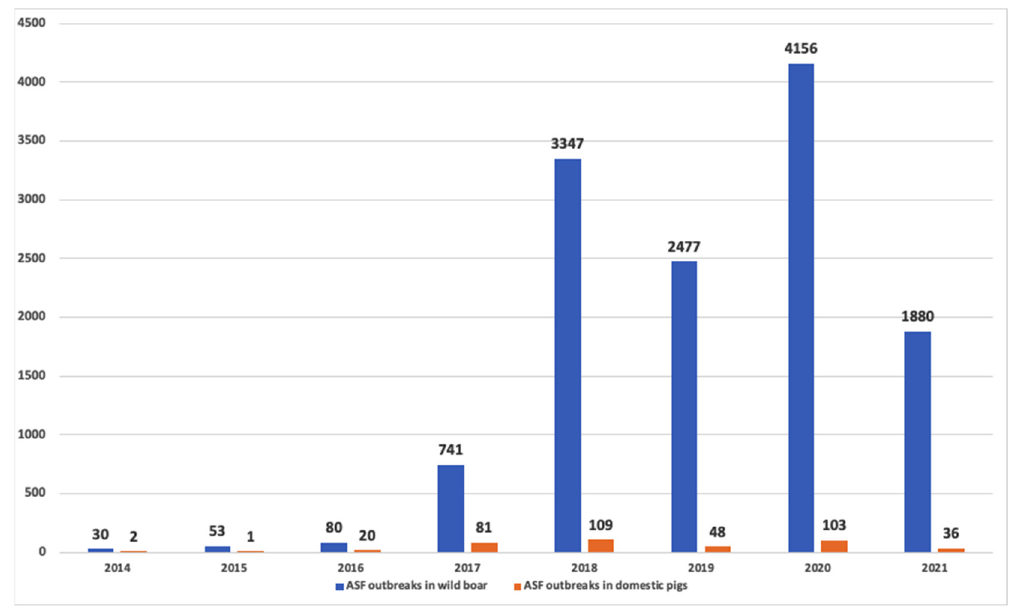
Figure 1. African swine fever in Poland 2014–2021. The number of ASF outbreaks in wild boar and domestic pigs. Source: General Veterinary Inspectorate: https://bip.wetgiw.gov.pl/asf/mapa/ (accessed on 30 July 2021).